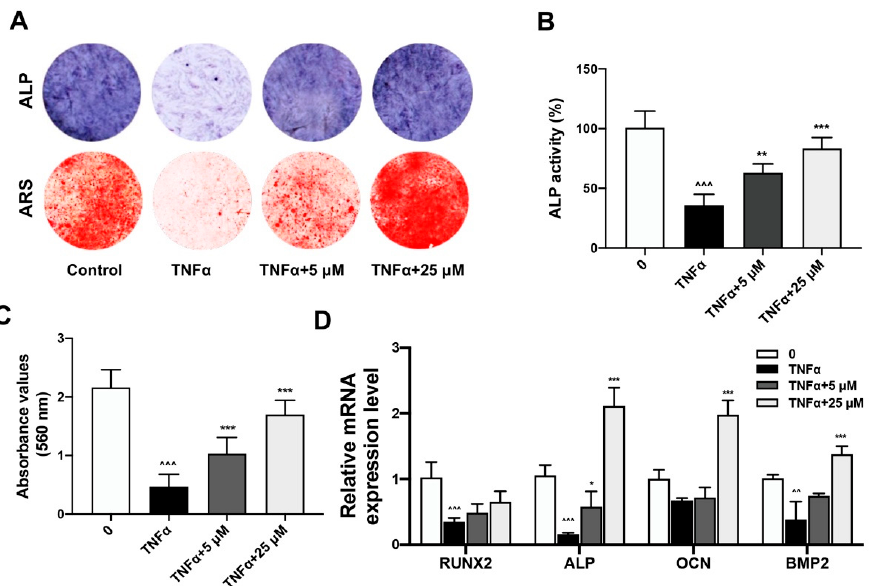
Figure 2. Quercetin rescued TNF α -impaired BMSCs osteogenesis. ( A ) The ALP staining at day 7 and the ARS staining of calcified nodules at day 14 after osteo-induction was performed. ( B , C ) Quantitative analysis of ALP activities ( B ) and ARS staining intensities ( C ). ( D ) The mRNA expression level of osteogenesis markers, including Runx2, Alp, Ocn and Bmp, were measured by real- time PCR after treatment with quercetin after osteo-induction for 7 days ( n = 6; ^^ p < 0.01, ^^^ p < 0.001 versus the Control group; * p < 0.05, ** p < 0.01, *** p < 0.001 versus the TNF α treatment group). The regulating effects of quercetin on Wnt/ β -catenin and NF- κ B signaling were fur- ther analyzed. The NF- κ B p65 and β -catenin nucleus translocation in BMSCs pretreated with TNF α and administrated with quercetin were analyzed by Western blotting (Figure 3A, Supplementary Figure S1). TNF α pre-treatment could repress Wnt/ β -catenin and ac- tivate NF- κ B signaling activities in BMSCs by decreasing nucleus β -catenin while increas- ing NF- κ B p65 nucleus translocation. Administration of 25 µM quercetin subsequently promoted nucleus β -catenin while inhibiting cytosolic and nucleus NF- κ B p65 levels in a dose-dependent manner. Furthermore, immunofluorescence (IF) staining analysis also demonstrated the rescuing role of quercetin on β -catenin and NF- κ B p65 nucleus translo- cation of the BMSCs impaired by TNF α (Figure 3B).